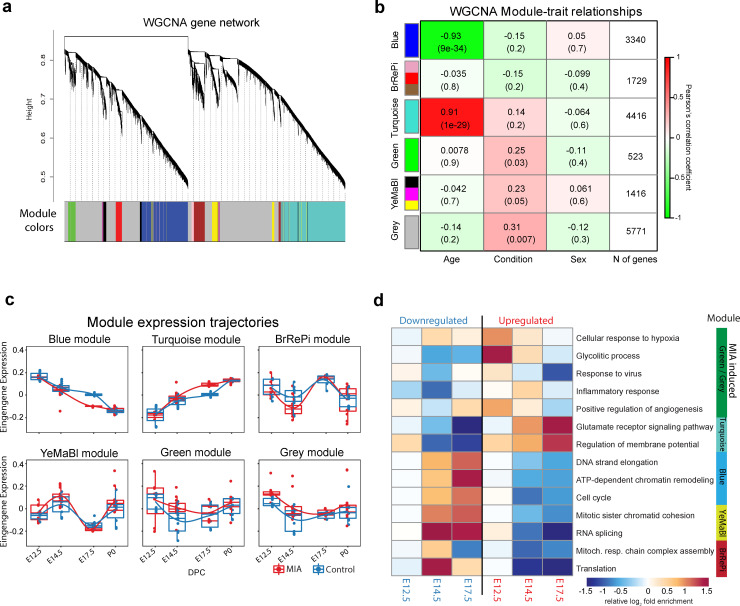
Weighted gene co-expression network analysis (WGCNA) reveals discrete gene networks perturbed by MIA across embryonic cortical neurodevelopment.(a) WGCNA cluster dendrogram of time series samples identifies genes that were assigned into co-expression modules. Based on similarities in module gene expression, six of the original 10 modules were grouped into two larger modules, BrRePi: Brown, Red and Pink; YeMaBl: Yellow, Magenta and Black. (b) Heatmap of correlation between gene expression modules and experimental traits; age, condition (saline vs poly(I:C)), and sex. Blue and Turquoise modules are strongly associated with age; Green and Grey modules are significantly associated with MIA condition. Numerical values represent signed Pearson’s correlation coefficients, with Student asymptotic p values in brackets. Green represents negative and red represents positive correlation. Color intensity signifies the strength of the correlation. (c) Module eigengene expression for MIA and control groups plotted by time-point illustrates expression trajectories across developmental stages, capturing module- and stage-specific differences between MIA and control groups. (d) Heatmap of enrichment of DE genes for representative gene ontology biological processes (GO BP) by developmental time-point shows stage- and module-specific transcriptional pathology. Y-axis rows show enrichment for GO BP terms among module-specific DE genes (FDR < 0.05). Heatmap color scale represents relative fold enrichment for the GO terms among DE genes. P0 not shown due to insufficient DE gene numbers and absence of GO BP terms passing enrichment criteria.